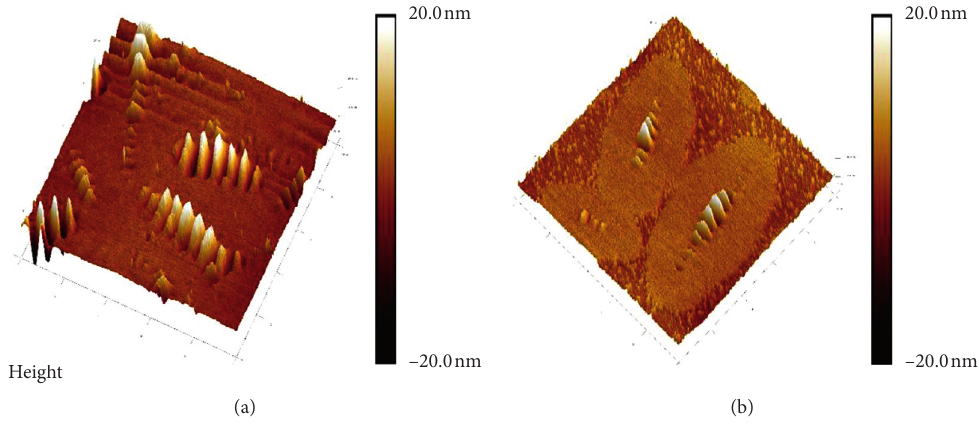
Figure 5: 3D AFM image of the (a) MRMA and (b) MA.